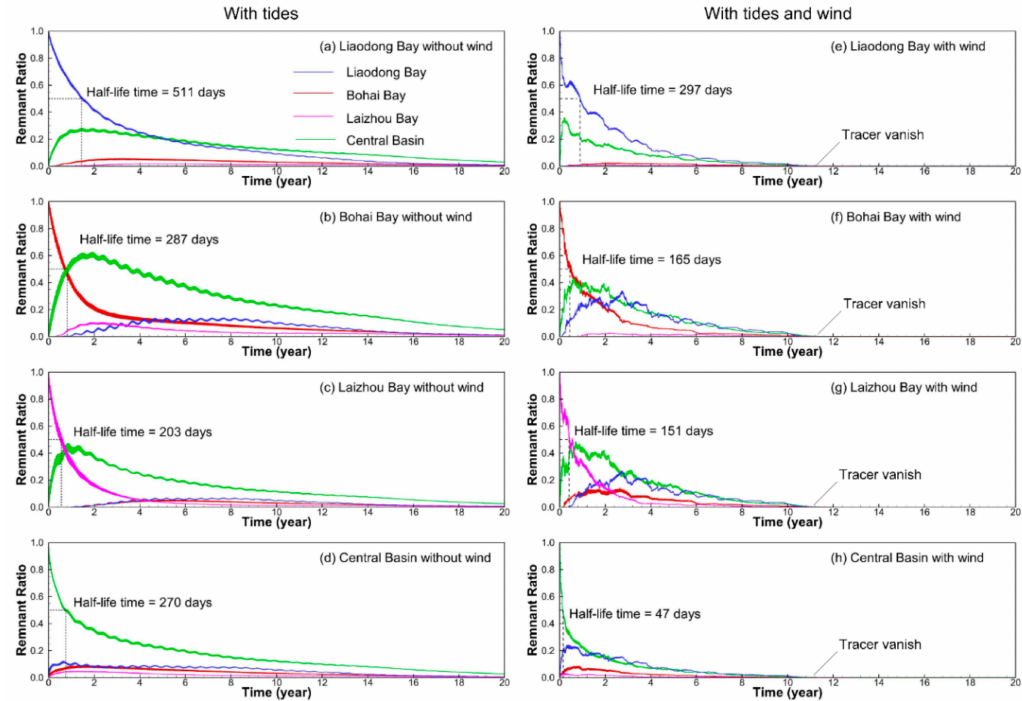
Figure 9. Remnant ratios of tracers initially residing in the four regions. The first day is 1 January 2010. ( a )–( d ) represent the situations only considering the tides and ( e )–( h ) represent the situations with both the tides and